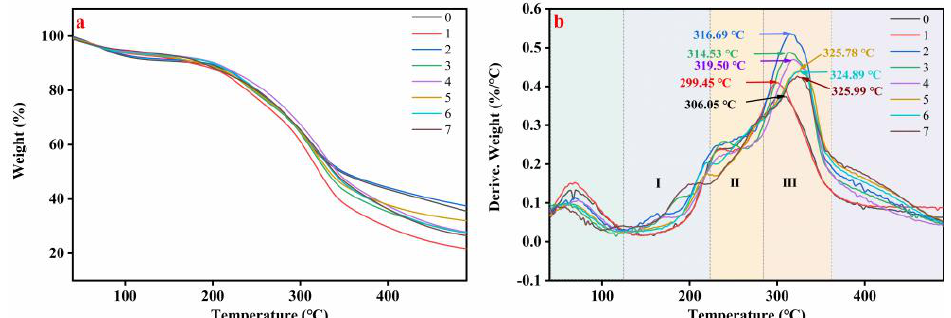
Figure 4. ( a ) Derivative thermogravimetric (DTG) and ( b ) thermogravimetric and curves of the dif- ferent adhesive samples: (0) HPM adhesive, (1) HPM-papain adhesive, (2) HPM-sodium dodecyl sulfate (SDS) adhesive, (3) HPM-urea adhesive, (4) HPM-PAE adhesive, (5) HPM-papain-PAE adhesive, (6) HPM-SDS-PAE adhesive, (7) HPM-urea-PAE adhesive.